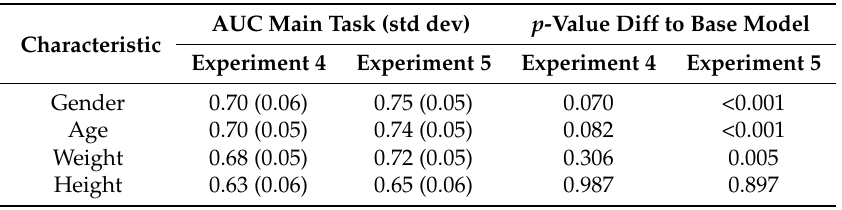
Table 6. Average AUC and the corresponding standard deviation of the main task (fall status), obtained when the ConvLSTM is applied to the test set. The p -value was obtained using the z -test to test the difference in the performance to the base